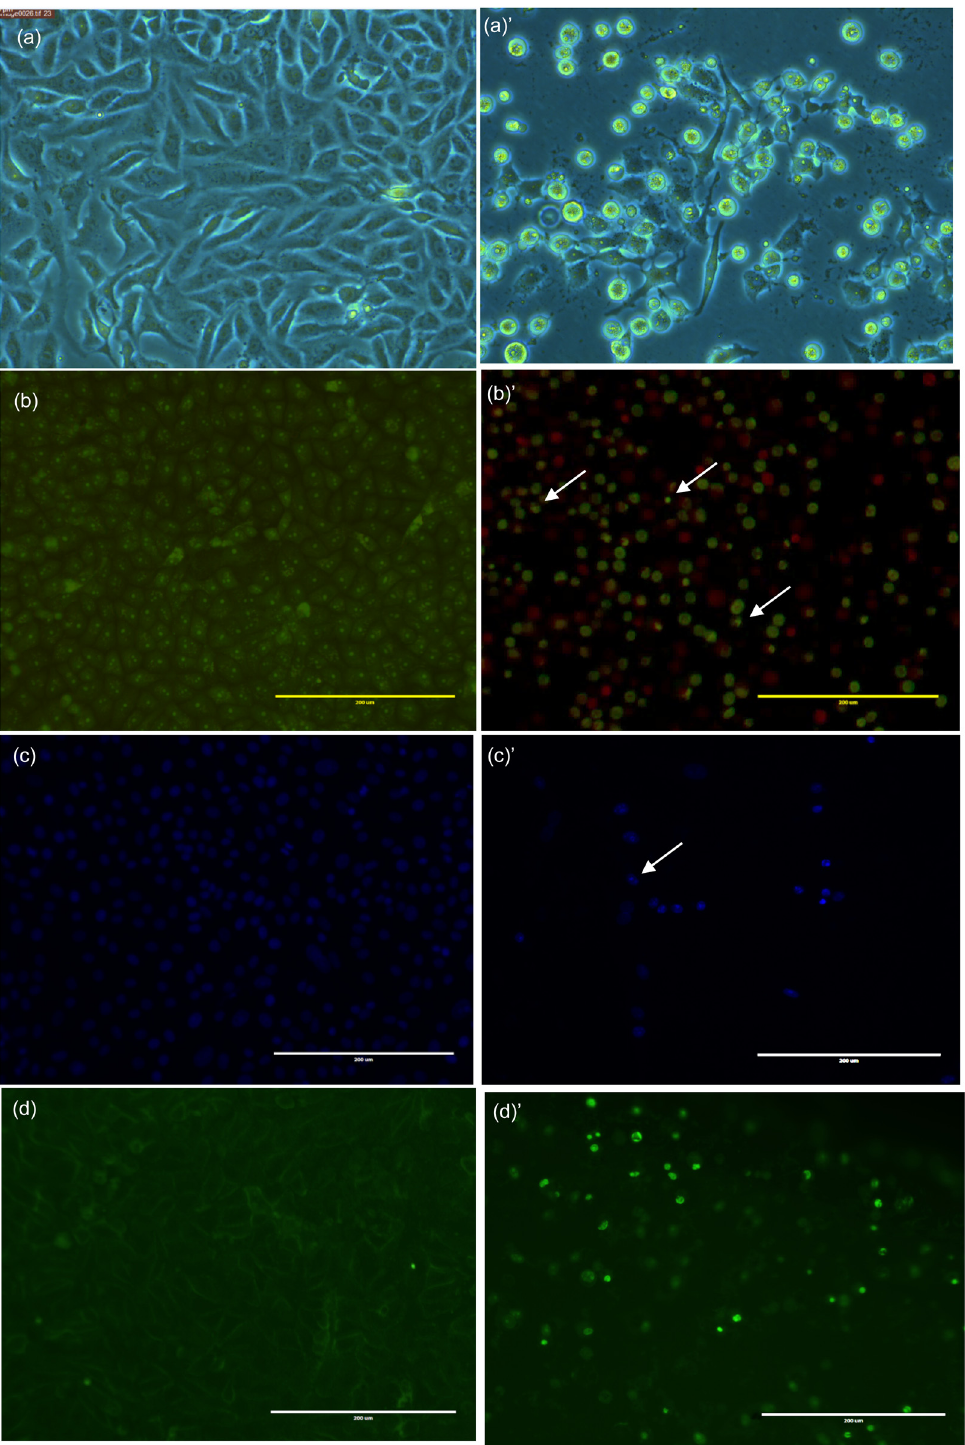
Figure 2: MCF7 cells were treated with 100 μ g/mL PHF5 extract for 48h. ( a ) Morphological changes in treated MCF7 cells where cell death occurred only in the treated cell. The number of cells decreased and fl oating cells were observed; ( a ) control cells, ( a ′ ) treated cells. ( b ) Cell apoptosis observed by acridine orange/ethidium bromide staining at 24h. Cells containing normal nuclear chromatin showed green nuclear staining ( b ) . Cells containing fragmented nuclear chromatin showed orange to red nuclear staining ( b ′ ) . ( c ) Apoptosis evaluated in MCF7 cells by nuclear staining with DAPI. Control cells treated with corn oil vehicle showed uniform nuclear staining ( c ) . Treated cells showed DNA condensation ( c ′ ) . The arrows indicate apoptotic cells. ( d ) Cell apoptosis was demonstrated by green fl uorescence using the caspase - 3/7 green detection reagent. Cells were stained for 30min and caspase - 3/7 activation was observed by fl uorescence microscopy; ( d ) control cells, ( d ′ ) treated